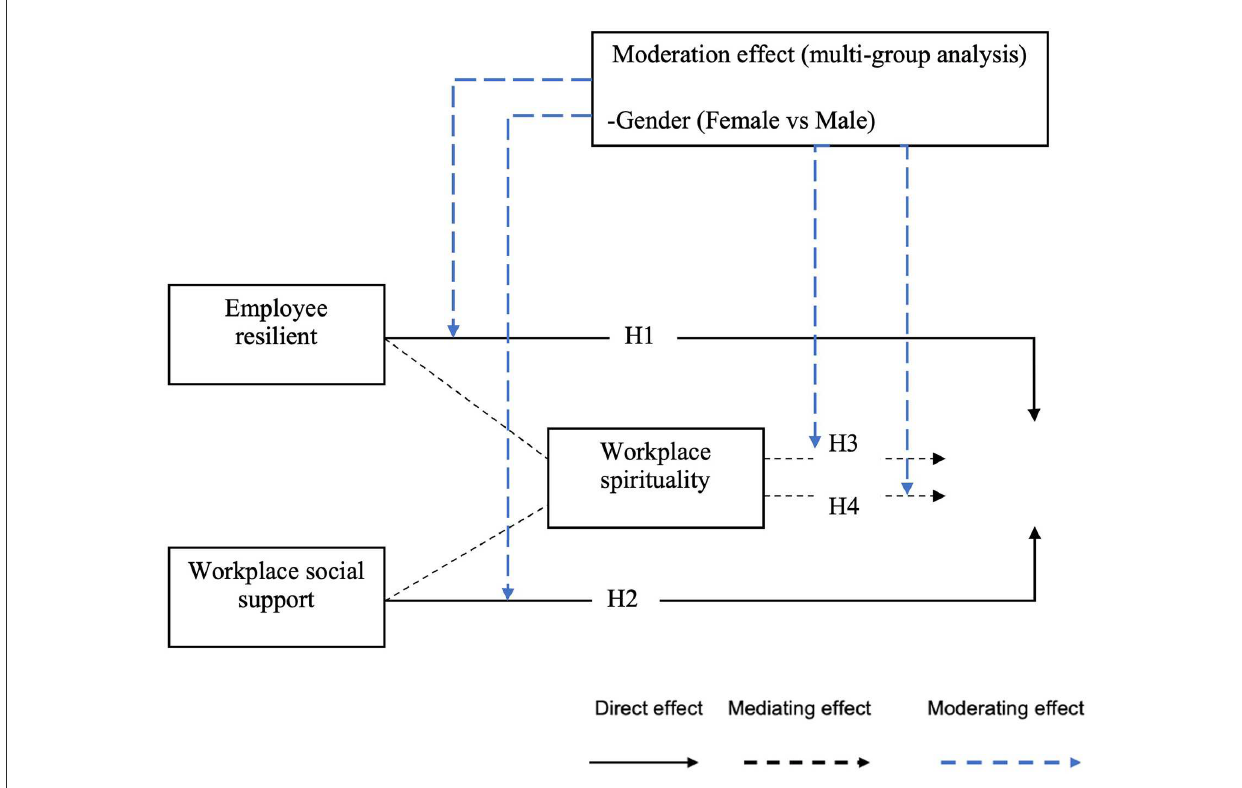
FIGURE1 Research